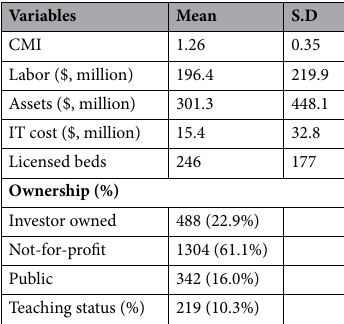
Table 1. Descriptive statistics for hospital financial variables and characteristics (unit: hospital year).